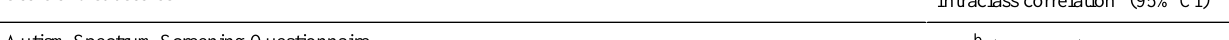
Intraclass correlation a (95% CI)Scale and